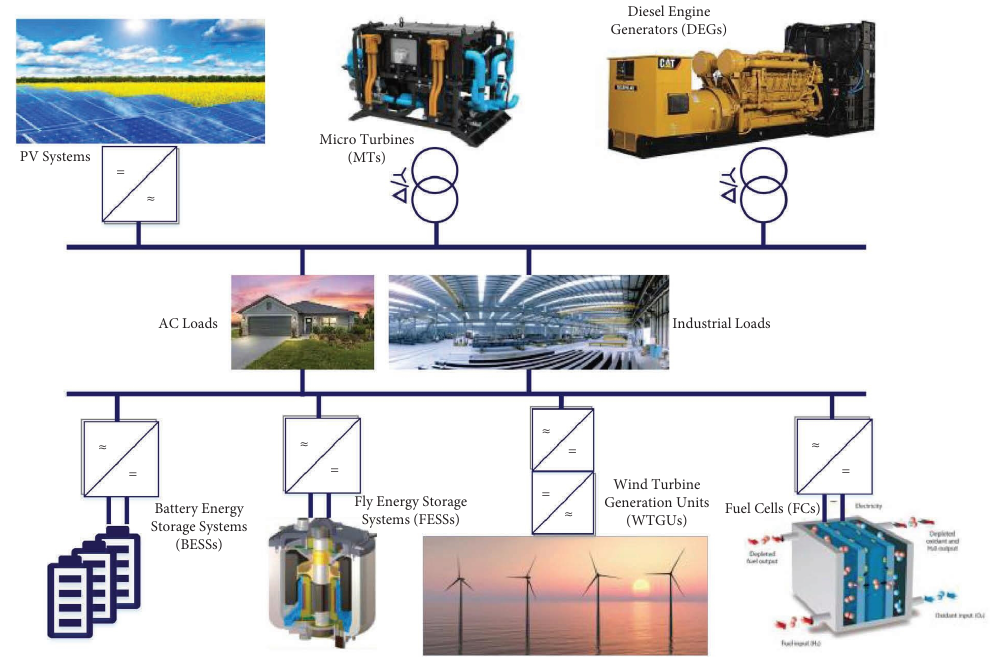
Figure 2: Simplifed illustration of an AC